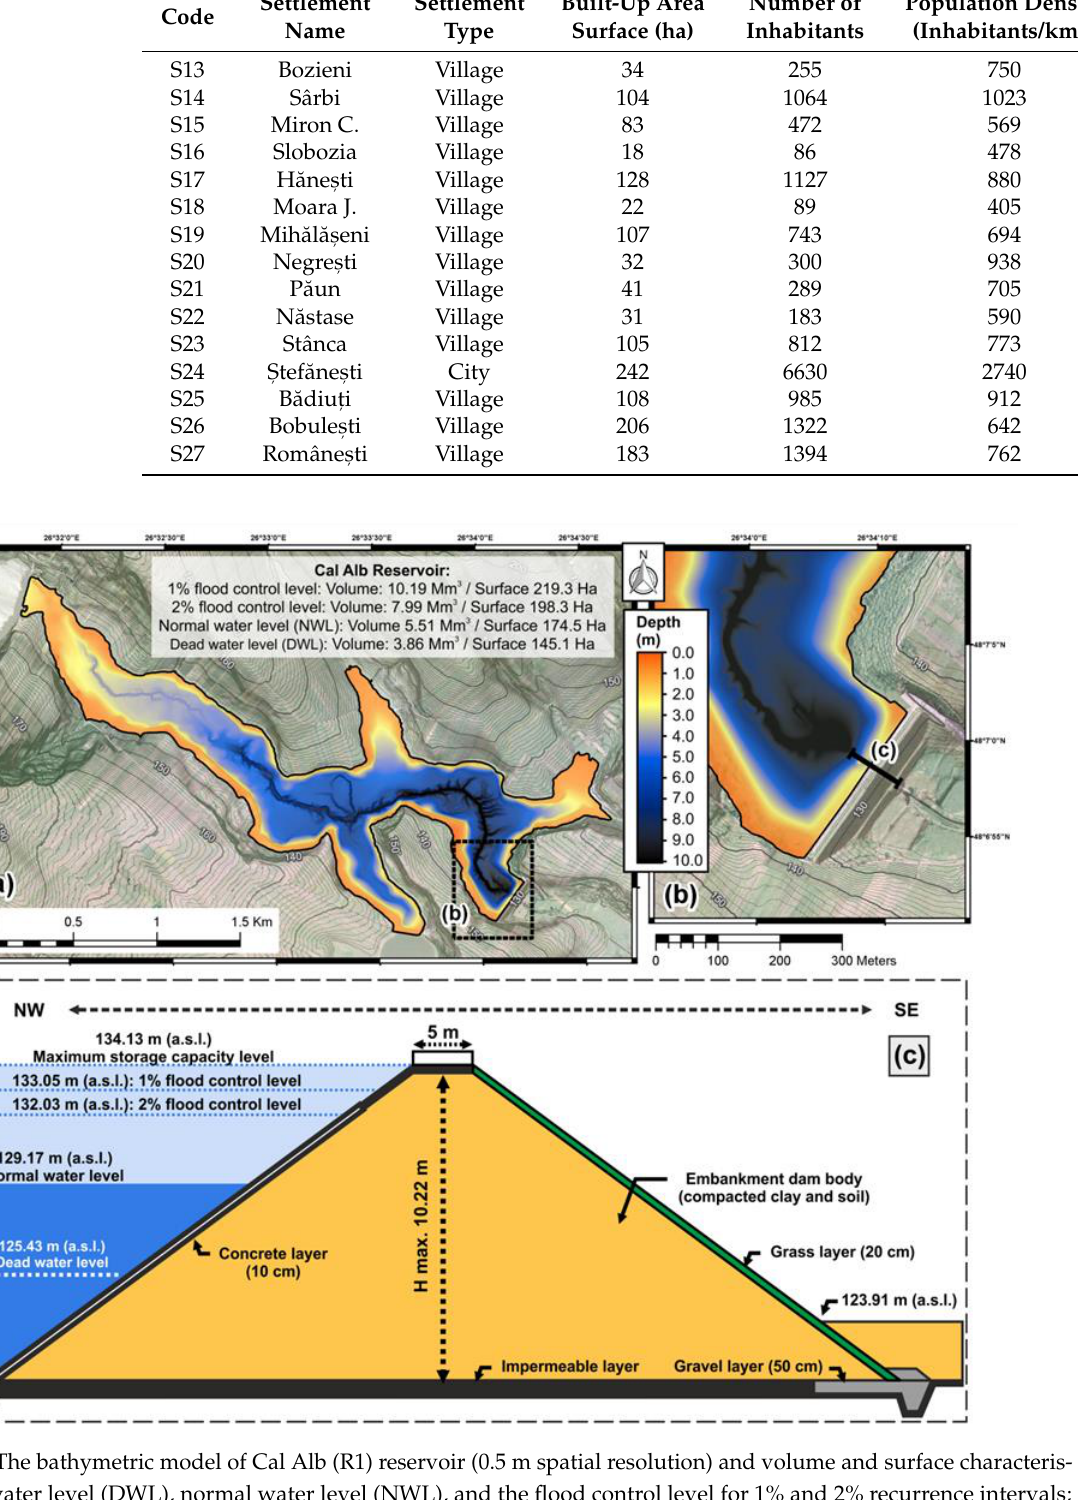
C 1 The percentage of the total storage capacity used as initial condition within two-dimensional (2D) HEC-RAS (Hydrologic Engineering Center River Analysis System, developed by USACE HEC, Davis, CA, USA) hydraulic model for each reser- voir.